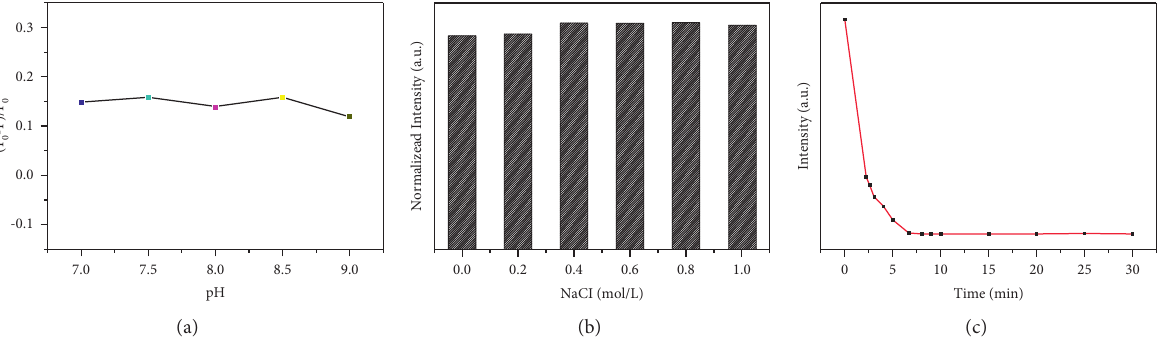
Figure 4: (a) Fluorescence quenching efficiency at different pH values. Normalized fluorescence intensity of CDs added to TNP at different NaCl concentrations (b) and incubation periods